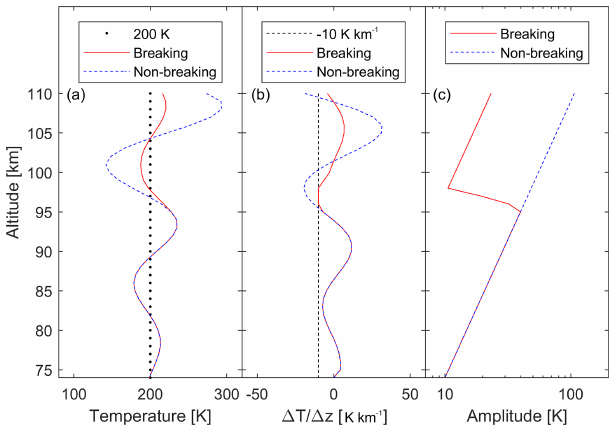
Figure 2. (a) Example of a wave of amplitude 10K at 74km al- titude perturbing an isothermal atmosphere at T = 200K (dotted black line). The dashed blue line represents the wave without any breaking, and the red line is the breaking wave as used in the model. (b) The rate of change of temperature with altitude for the wave shown in (a) . When the temperature changes faster than 10Kkm − 1 (dashed black line) the wave breaks. (c) At these altitudes, the am- plitude of the breaking wave (red line) decreases, while the non- breaking wave continues to grow exponentially (dashed blue